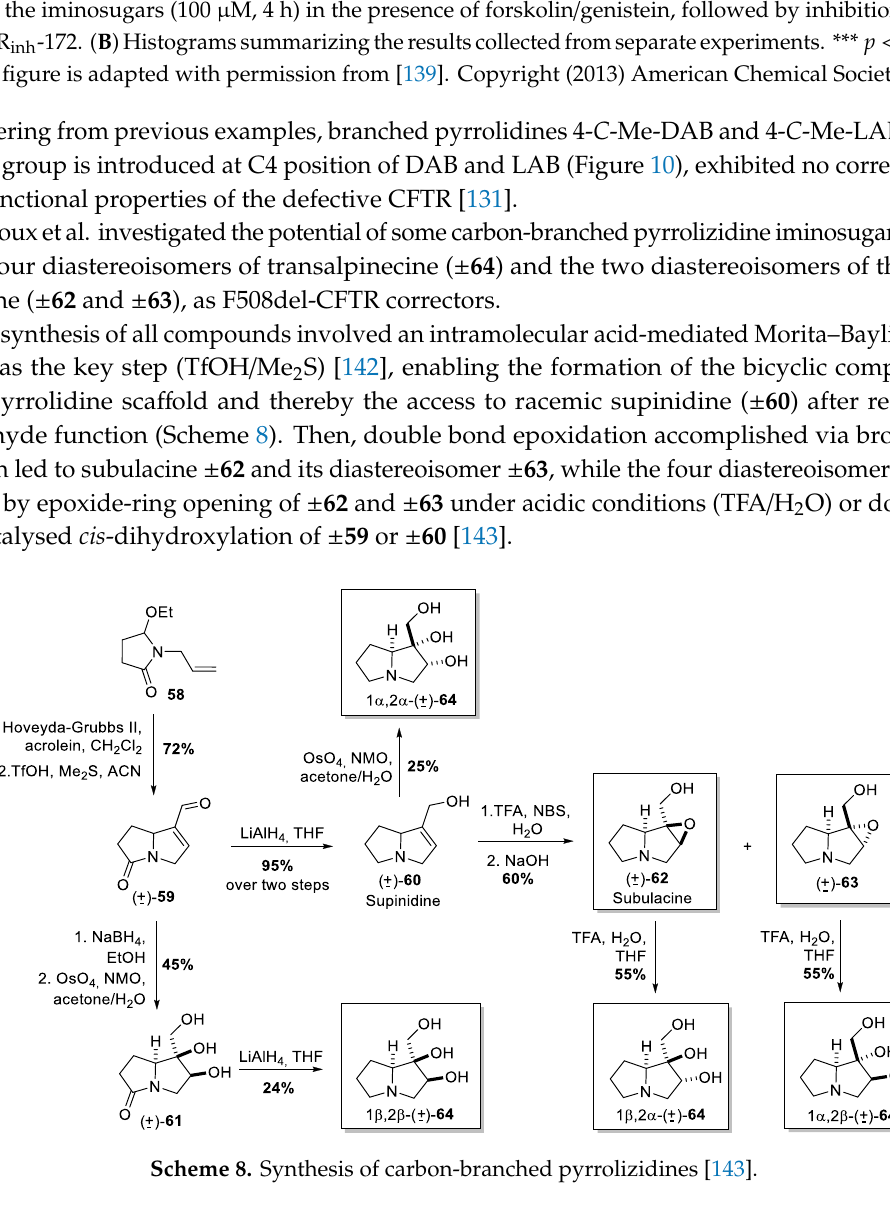
Figure 13. Transepithelial short-circuit currents (Isc) recorded in F508del-CFTR-expressing CFBE cells. ( A ) Protocols used and model trace indicating ΔIsc. ( B – D ) Tracings of Isc recorded with CFBE cells incubated with: ( B ) DMSO or VX-809 (10 μM) (24 h); ( C ) water or 63 (100 μM) (4 h); ( D ) VX-809 (10 μM, 24 h) or VX-809+ 63 (100 μM, 4 h). F508del-CFTR was activated by application of CTR activators and inhibited by CFTRinh172. ( E ) Summary of the ratio ΔIsc/ΔIsc VX-809 for each compound; ** p < 0.01. A ratio above 1 means a potentiation. This figure is adapted with permission from [143]. Pyrrolizidine iminosugars ± 62 , ± 63 and ± 64 were evaluated either alone or in combination with the corrector VX-809 (Lumacaftor) [144,145], which is one of the two components of the currently